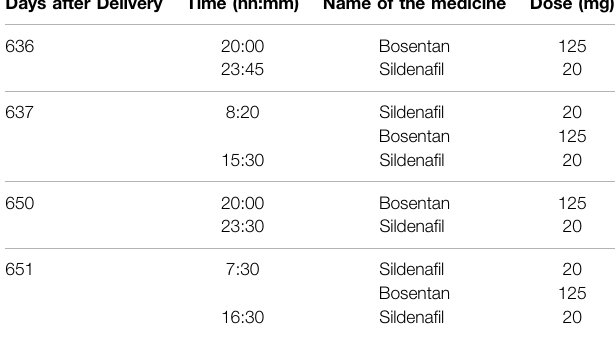
TABLE 1 | Overview of the timing and dosing of maternal medicines